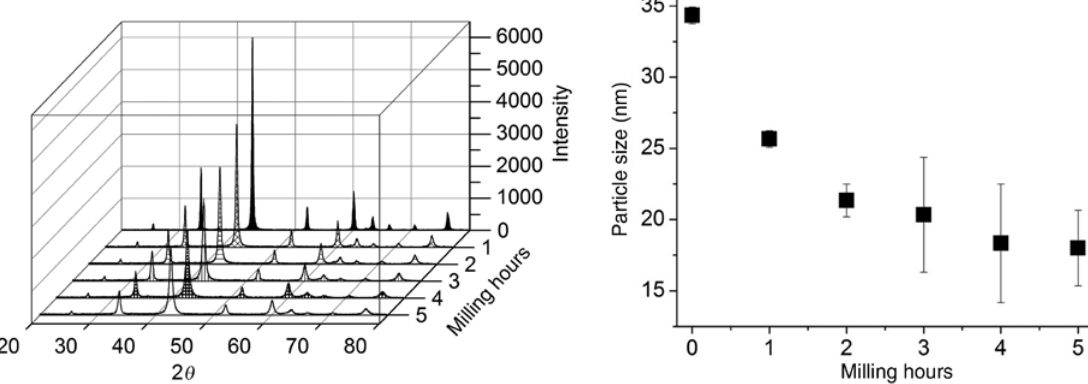
specimens at different milling hours. Figure 2: Average MgB 2